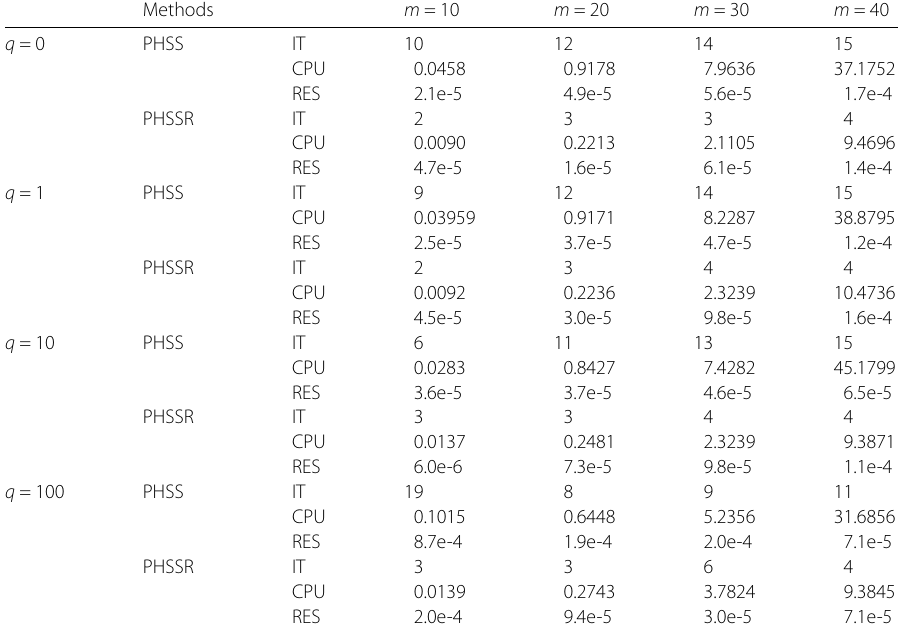
Table 1 Numerical results for the test problem with different values of m and q ( p = 0) Methods m = 10 m = 20 m = 30 m = 40 q = 0 PHSS IT 10 12